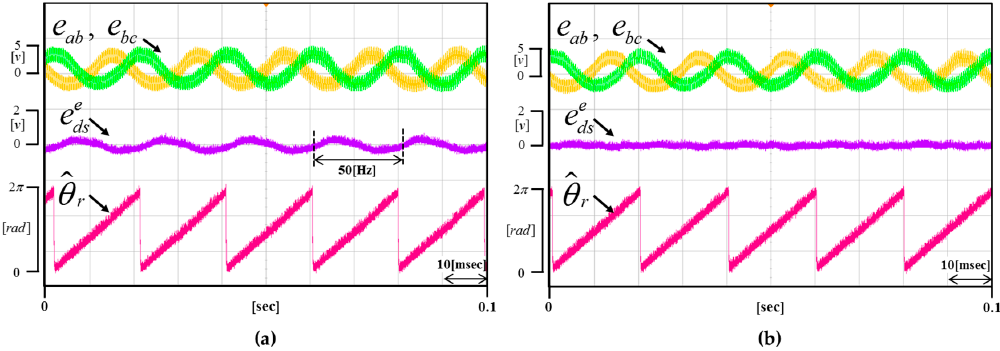
Figure 13. ( a ) Waveform of the not applied proposed method ( b ) Waveform of the applied proposed method (Operating condition: ω r = 1500 r/min).